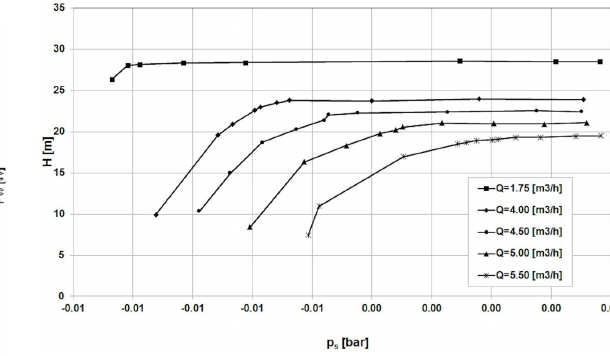
Figure 8: Cavitation curves of the Impeller 2